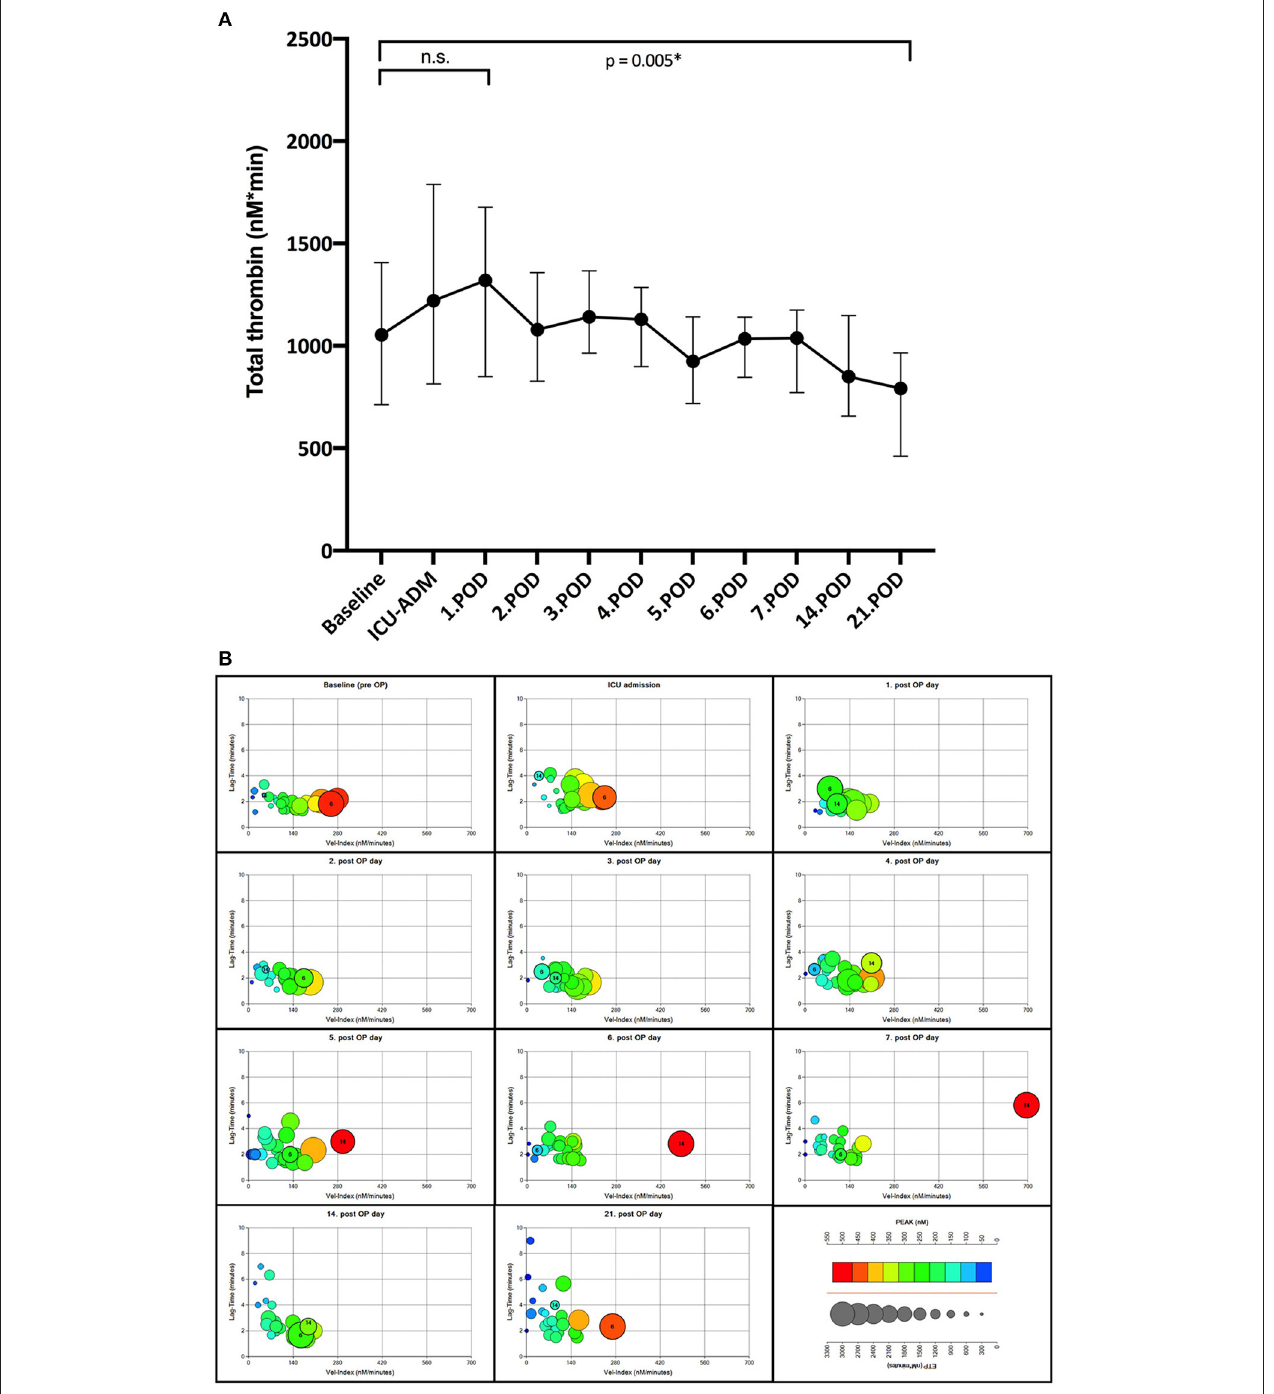
FIGURE 4 | (A) Time course of total thrombin. Total thrombin (nM*min) as measured by Thrombinoscope ® (Stago Austria GmbH, Vienna); POD, postoperative day; *Non-parametric Wilcoxon test for paired samples; n.s, not significant. (B) Thrombin generation phenotypes in the LVAD population. Each individual in the population is defined by four thrombin parameters and their phenotype represented graphically by a positioned colored circle: y -axis, lag time in minutes; x -axis, velocity index in nM/min (rate of thrombin generation); color, peak thrombin in nM (maximum thrombin level); and size, total thrombin in nM*min (ETP or endogenous thrombin potential). Patient N ◦ 6 developed heparin-induced thrombocytopenia (HIT) at POD 16; thrombin generation of Patient N ◦ 14 was boosted approximately 10-fold by a gram - positive sepsis.